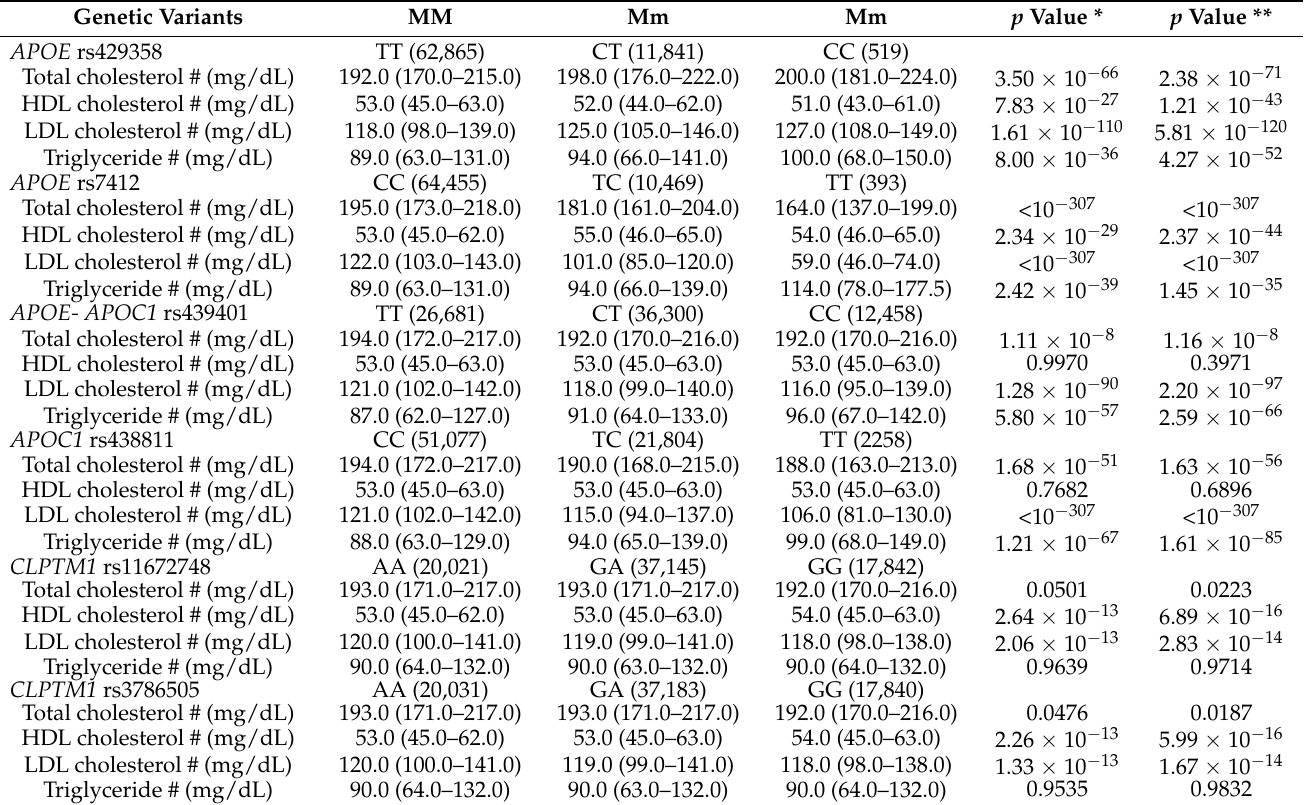
Table 2. Association between APOE , APOC1 , and CLPTM1 gene region variants and serum lipid